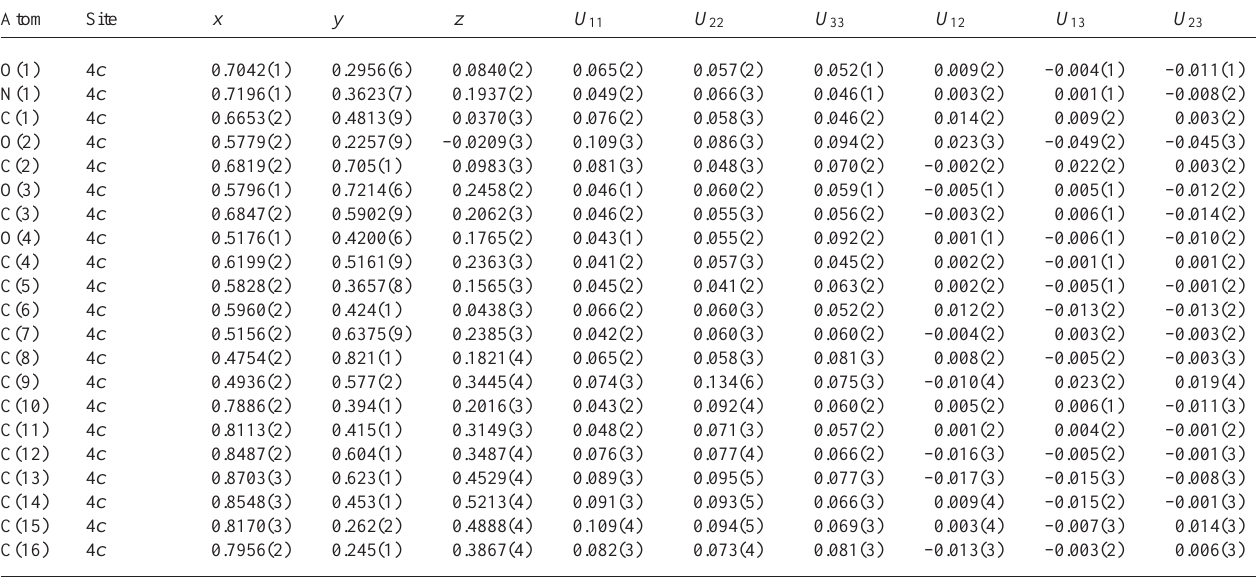
Table 3. Atomic coordinates and displacement parameters (in Å 2 )